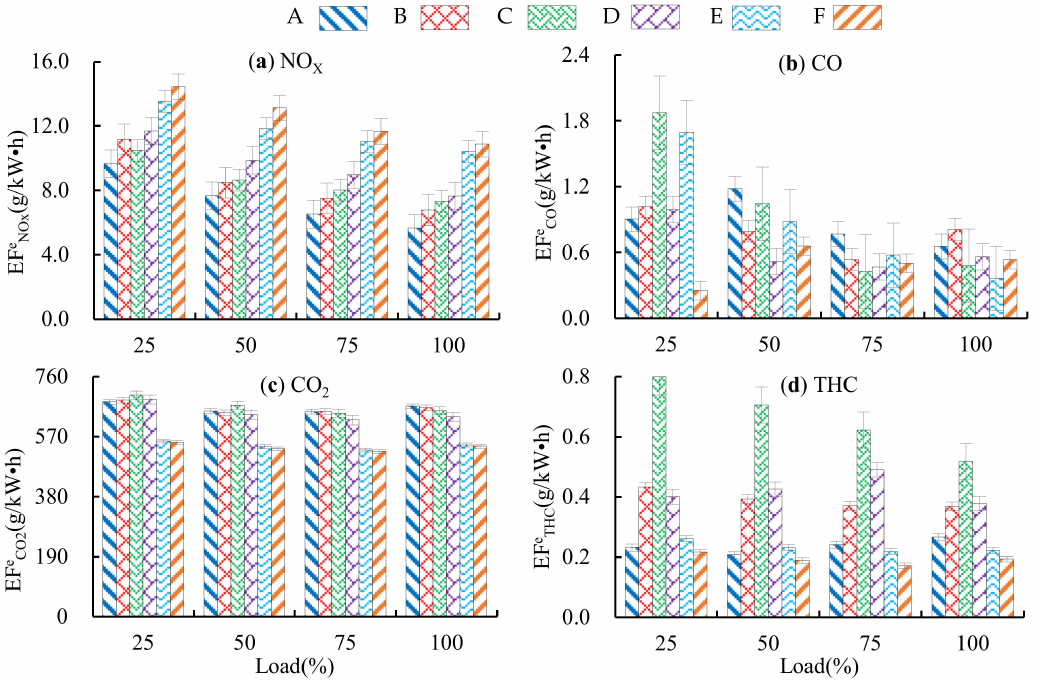
Figure 4. Relationship of energy-based emission factors against engine load for ME. Energy-based emission factors at four load points for the main engine. ( a ) NO X energy-based emission factors, ( b ) CO energy-based emission factors, ( c ) CO 2 energy-based emission factors, and ( d ) THC energy-based emission factors. The relationship between diesel engine power and speed is cubic equation.